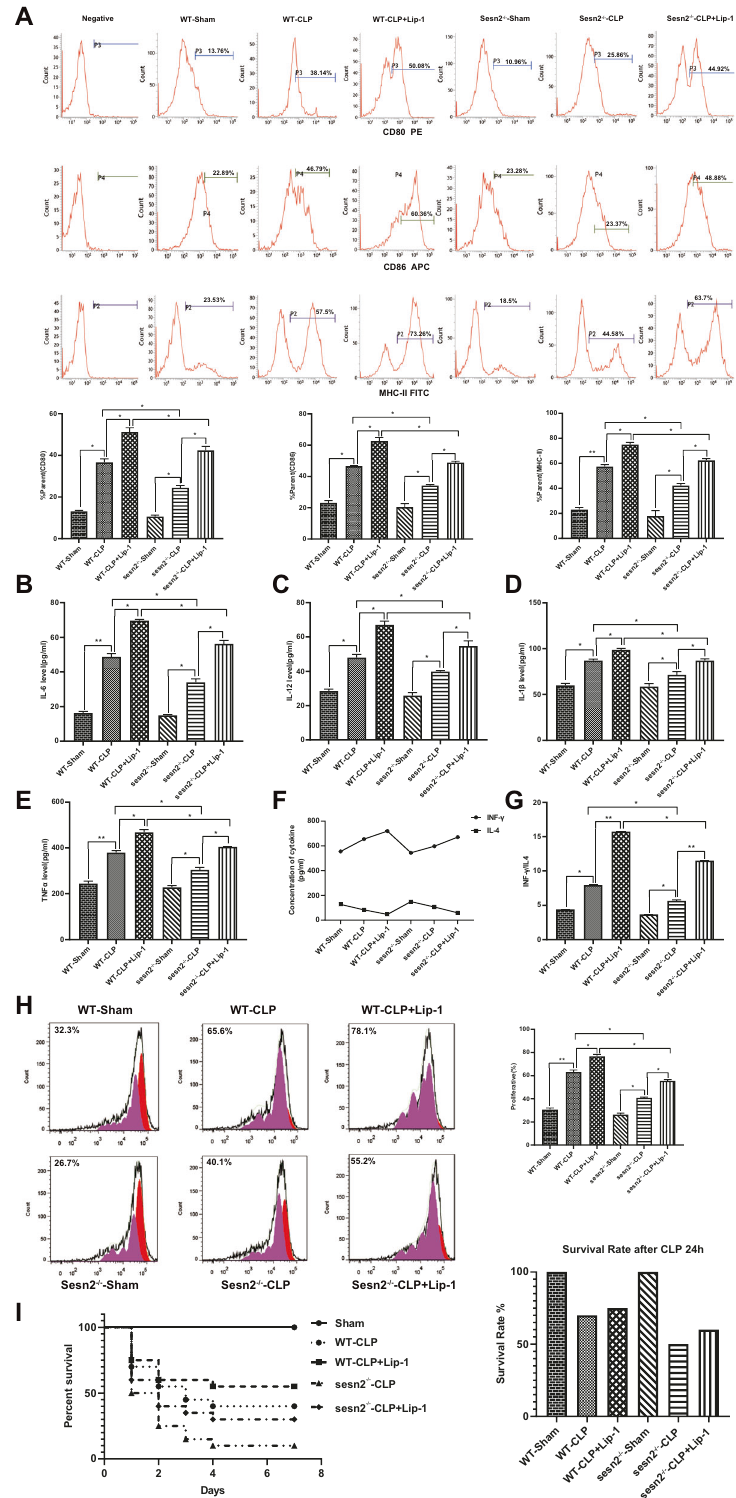
Fig. 6 Sesn2 downregulates sepsis-induced ferroptosis to protect the immune response of DCs. Mice were intraperitoneally preinjected with Lip-1 at 10 mg/kg and underwent severe CLP 1 h later. Mice in the control group underwent a sham operation. A The percentage of co-stimulatory phenotypes expressed on DCs was measured by fl ow cytometry. B – E The release of in fl ammatory cytokines re fl ecting the degree of DC maturity and secretion was detected by ELISA after CLP. F , G DCs extracted in CLP with injection of Lip-1 or without Lip-1 were cocultured with CD4 + T cells incubated with Con A. Afterwards, IFN- γ contents and IFN- γ /IL-4 ratios were determined by ELISA to evaluate Th1/Th2 polarization. H DCs from CLP mice treated with or without Lip-1, were cocultured with CD4 + T cells stained with Con A, and then T-cell proliferation induced by DCs was measured by fl ow cytometry. I Mice were treated with Lip-1 at a concentration of 10 mg/kg and underwent severe CLP 1 h later. Data from three independent experiments were presented as the mean ± SD ( n = 3 per group). Statistical signi fi cance: * P <0.05, ** P <0.01 vs. the control